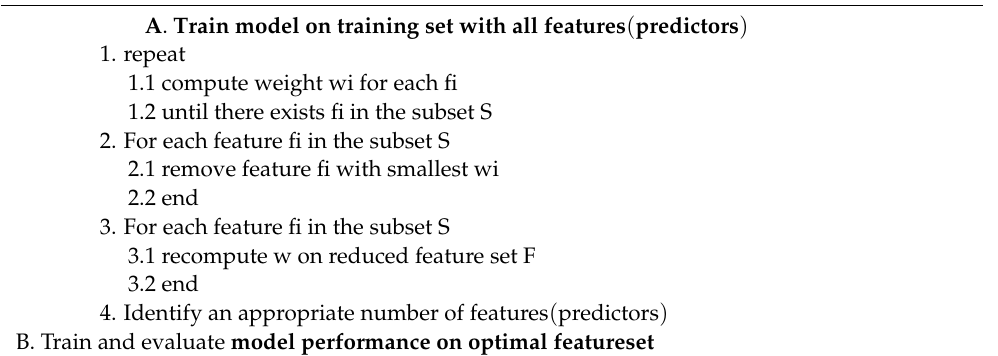
Algorithm 2. Optimal feature selection using recursive feature elimination.